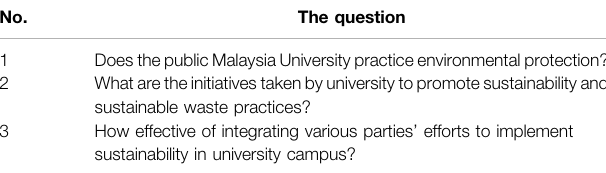
TABLE 1 | The questions raised by this work.